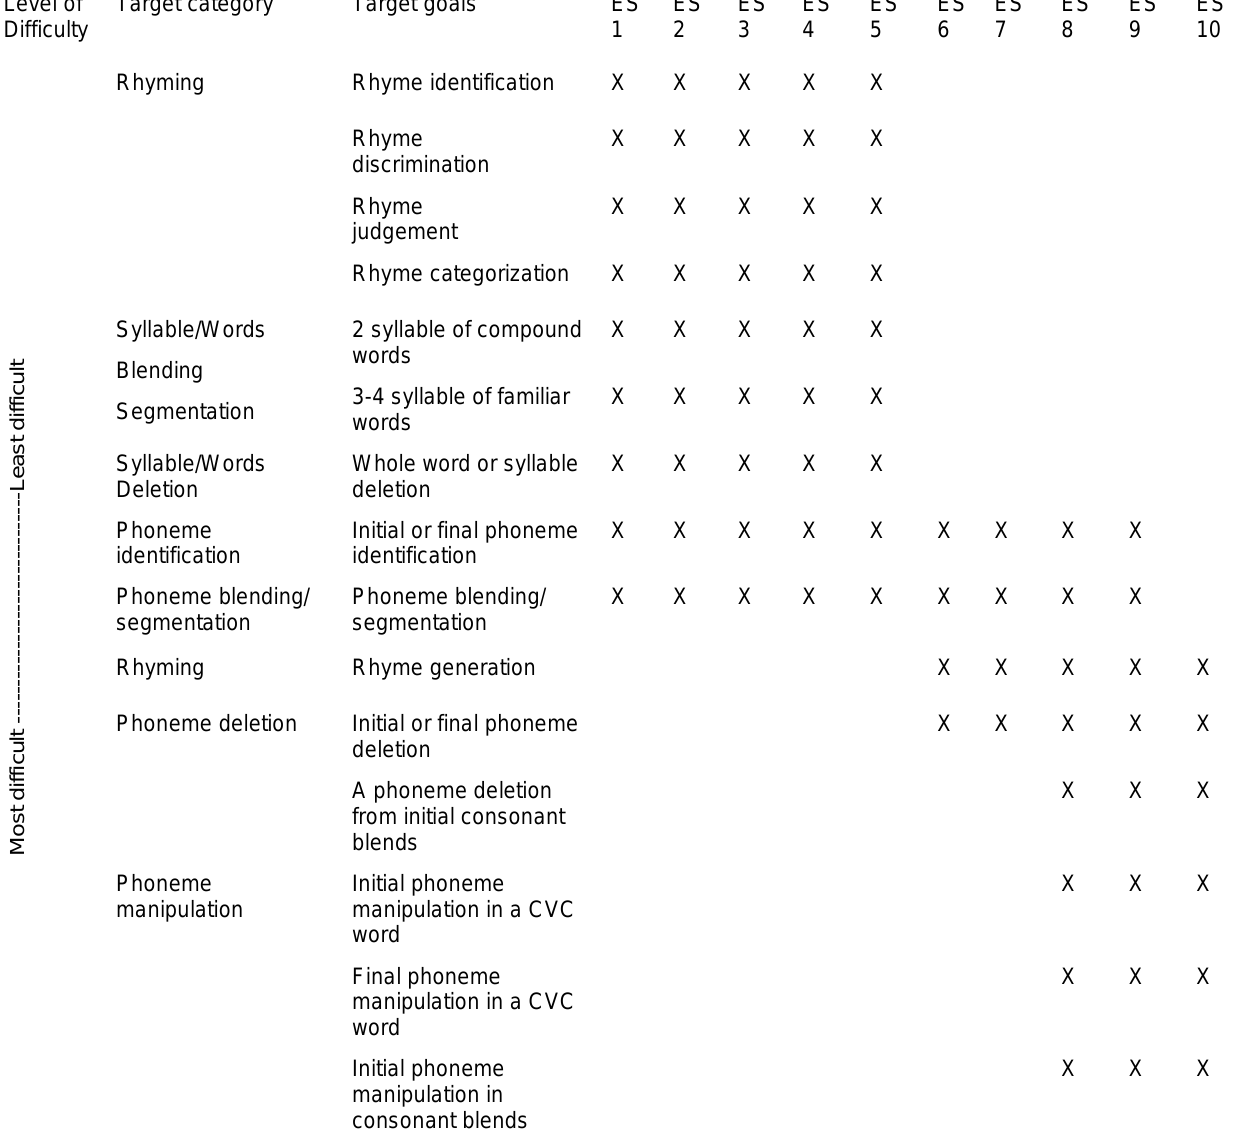
Table 3. Phonological Awareness Skills Targeted for Telepractice Group Participants Level